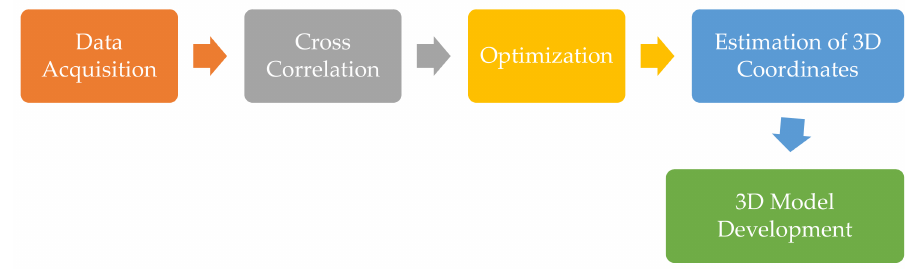
Figure 5. Proposed method for source localization in 3D